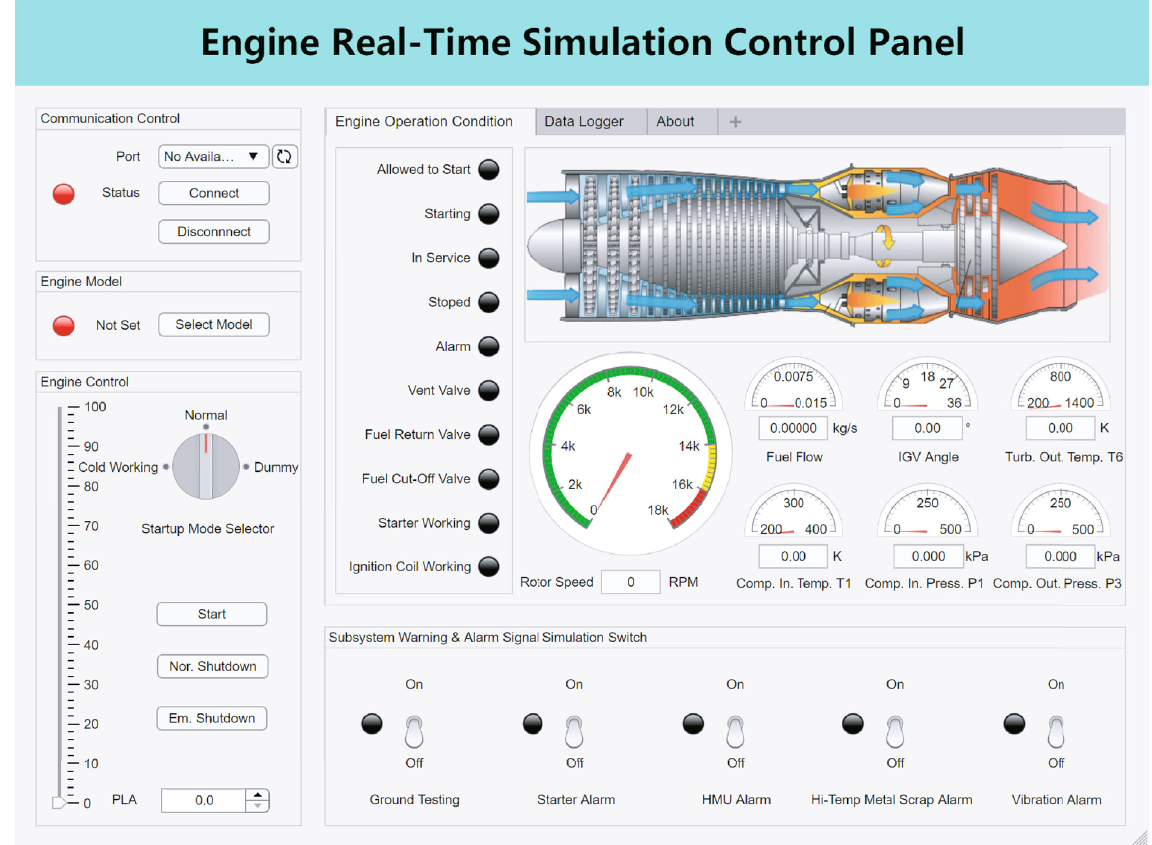
Figure 14: The interface of the host